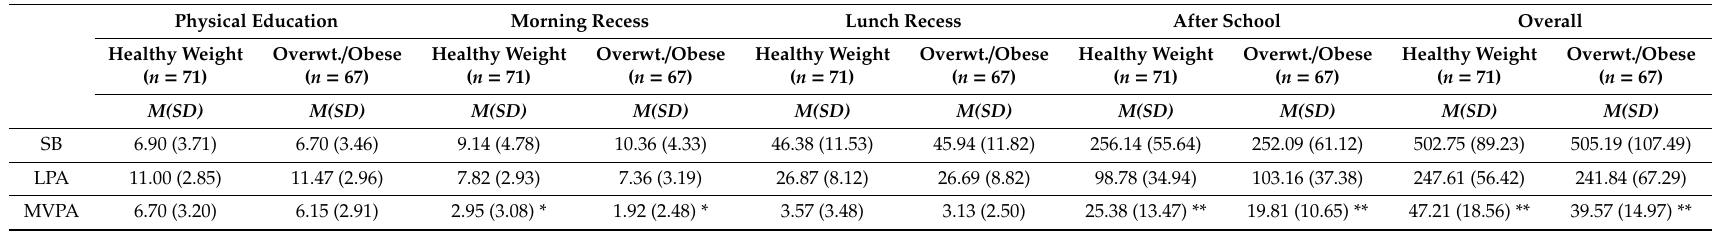
Table 2. Duration of Physical Activity a by BMI during Di ff erent Daily Segments and